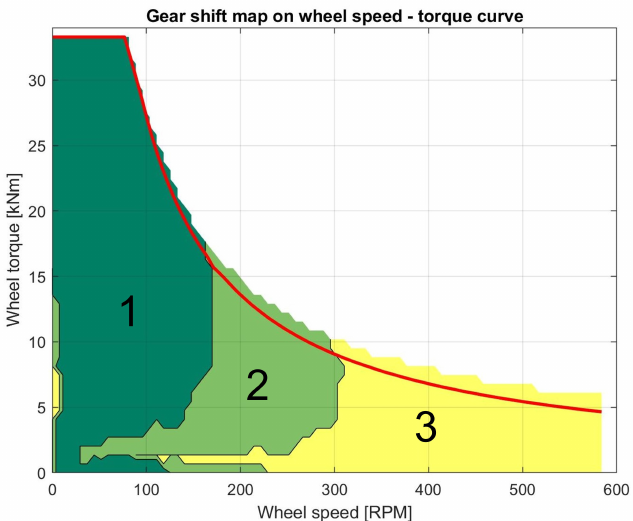
Figure A1. Optimal gear shift pattern depending on wheel speed and requested torque based on local minimisation of eDrive